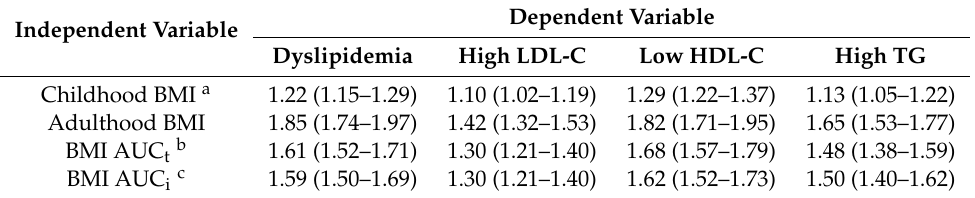
Table 3. Standardized odds ratios (ORs) and 95% confidence intervals (CIs) of BMI measures for adult